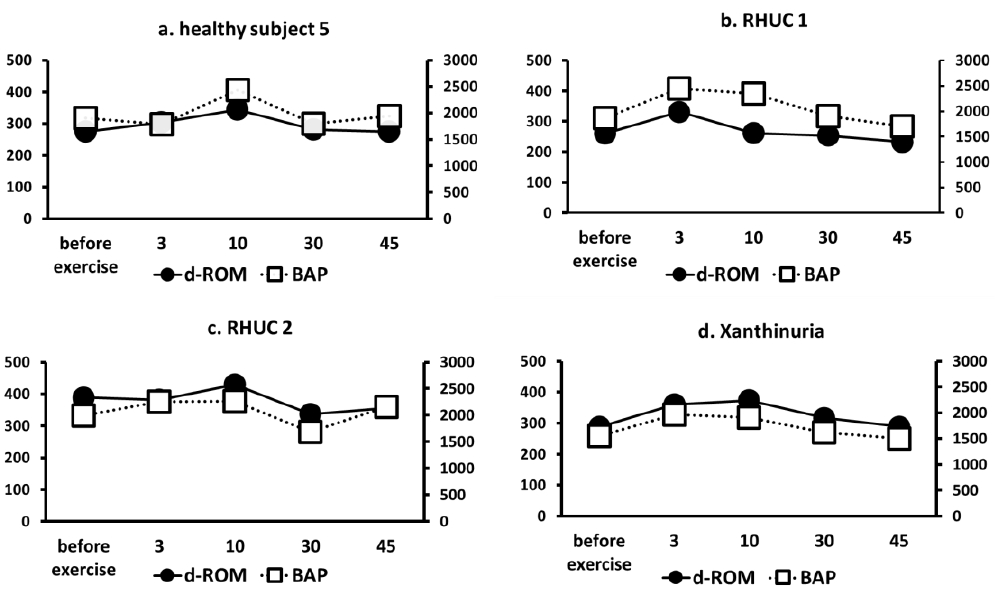
Figure 7. Changes of ROS markers d-ROM and antioxidant capacity marker BAP. ( a ) : Healthy subject 5. ( b ): RHUC 1. ( c ): RHUC 2. ( d ): XU. Units on the left vertical axis are U-CARR (d-ROM), units on the right vertical axis are μmol/L (BAP), and the horizontal axis is time (minutes). ROS, reactive oxygen species; d-ROM, dicron-reactive oxygen metabolite; BAP, biological antioxidant potential; RHUC, renal hypouricemia; XU, hereditary xanthinuria.